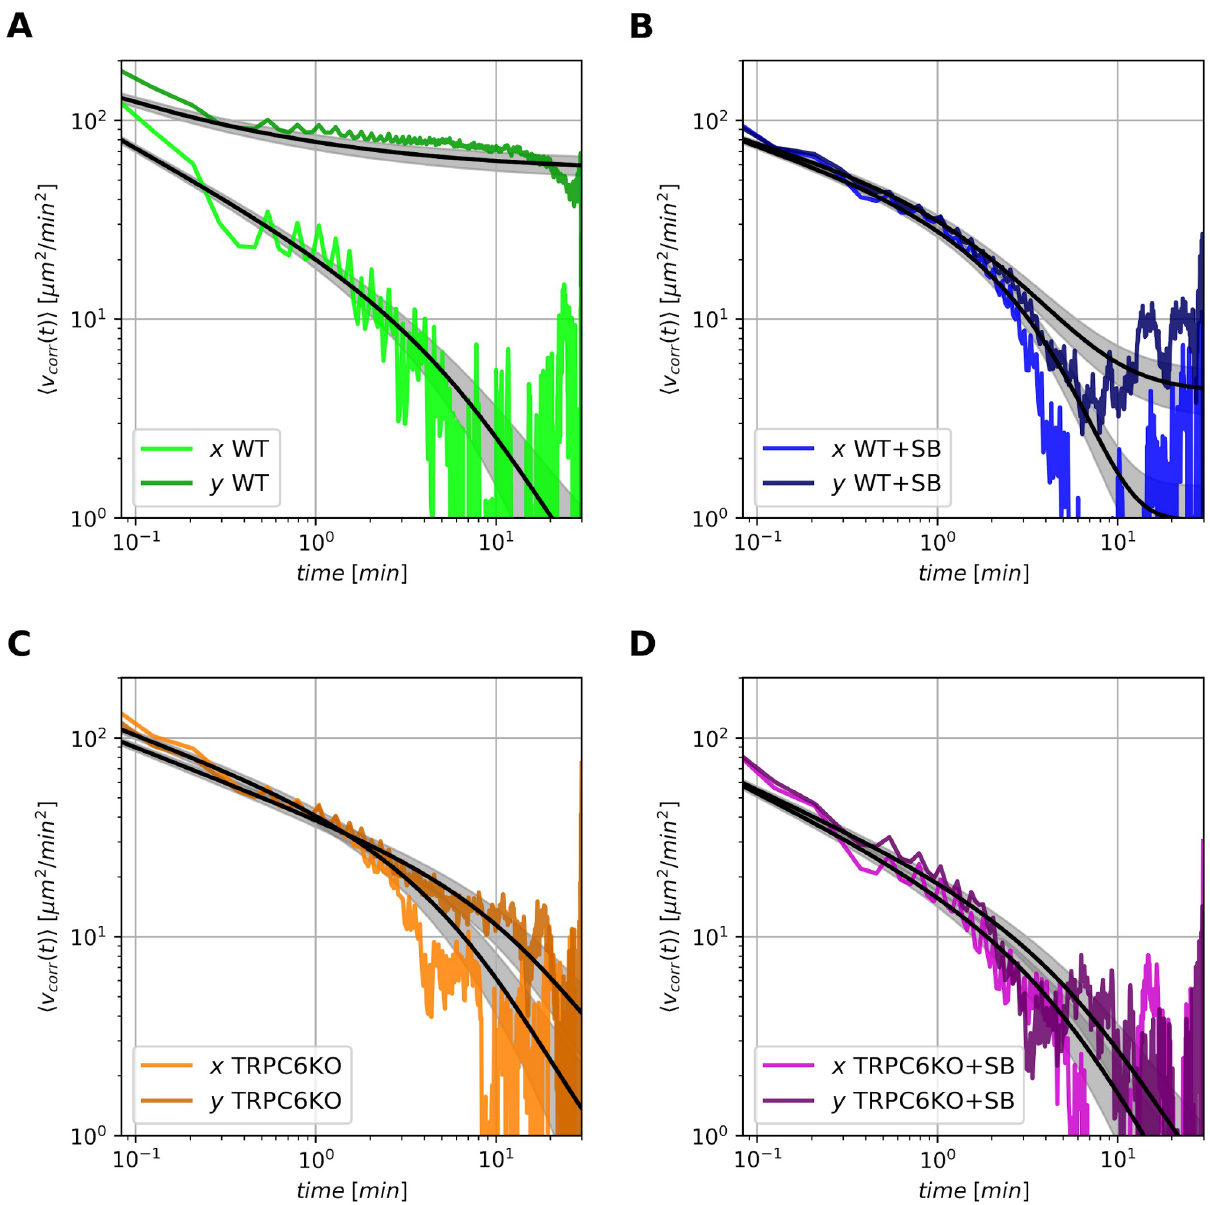
Fig 3. Velocity autocorrelation functions. The diagrams show the velocity autocorrelations in x - and y -direction. Thick colored lines indicate the corresponding time-ensemble-averaged velocity autocorrelation function h v ( t ) i as defined in Eq 22 with repect to x - and y -direction in bright and corr , x | y dark colors, respectively. The results of the best theoretical model are shown as black lines together with a grey area of uncertainty ( ± one standard deviation). (A) Murine wildtype neutrophils. (B) Wildtype neutrophils with CXCR2 blocker SB225002. (C) TRPC6 − / − neutrophils. (D) TRPC6 − / − neutrophils with CXCR2 blocker